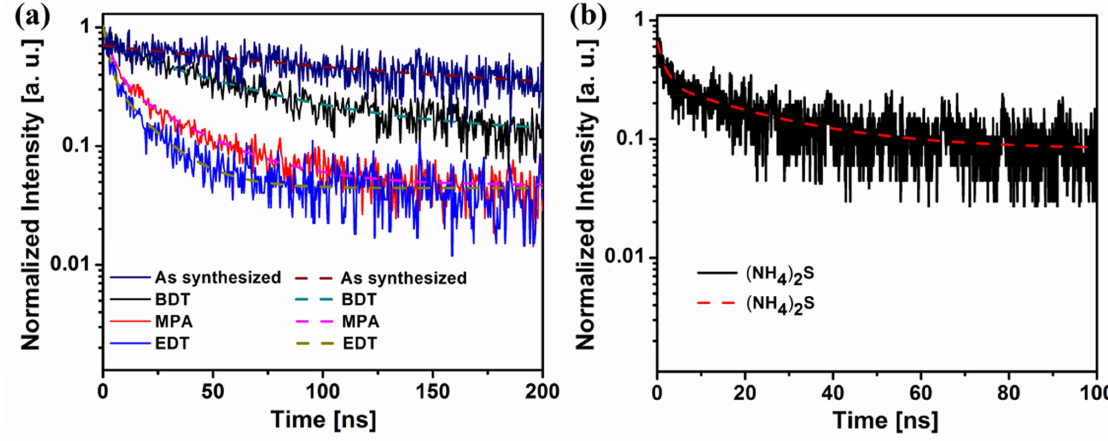
( a ) Time-resolved PL spectrum of the spin-cast QD film. Dark blue trace, as-synthesized oleic acid-capped film; black trace, 1,3-BDT-treated QD film; red trace, MPA-treated QD film; blue trace, EDT-treated QD film. ( b ) The (NH The dotted red line shows the bi-exponential fitting